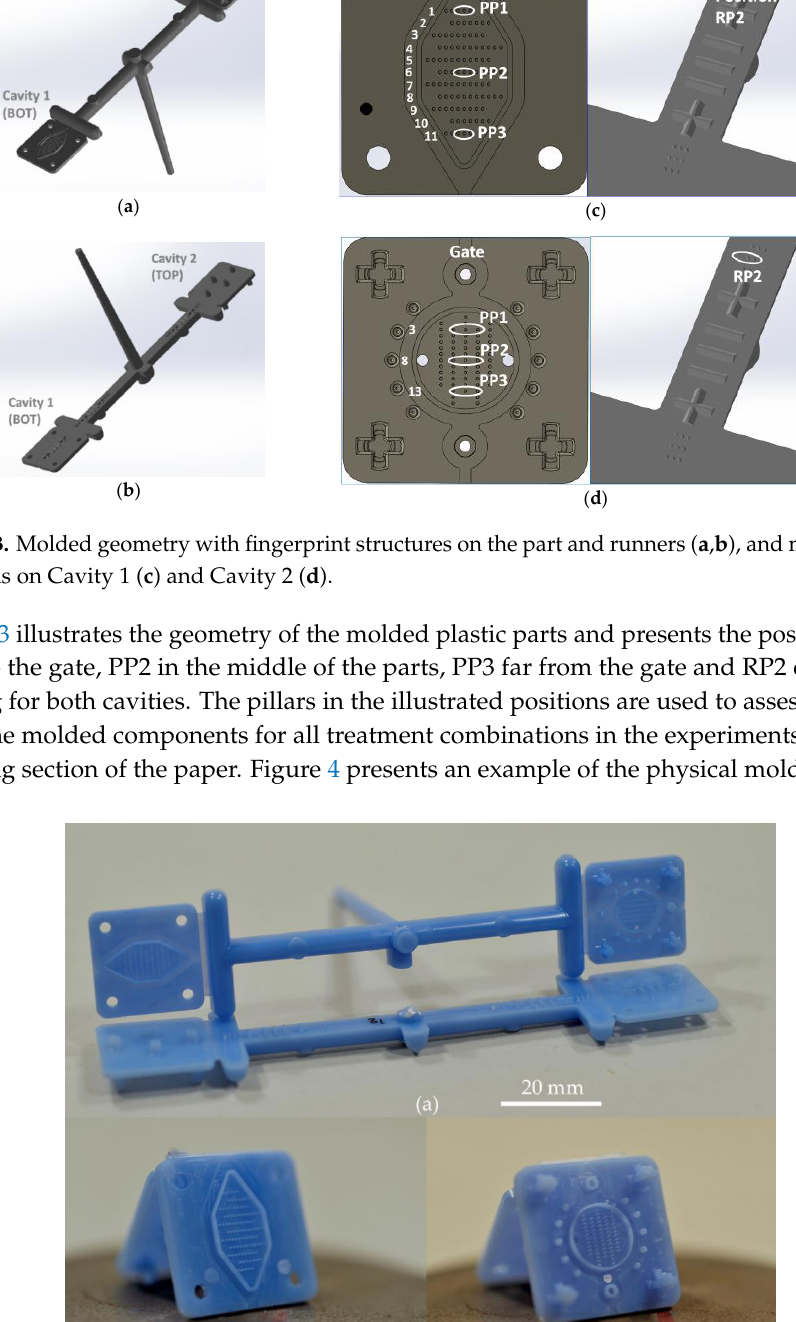
Figure 4. ( a ) Molded component with fingerprint structures on the part and runners. The fingerprints at the front (top) and back (bottom) side of the components are visible. ( b ) Bottom (Cavity 1) and ( c ) top (Cavity 2) parts of the microfluidic system.